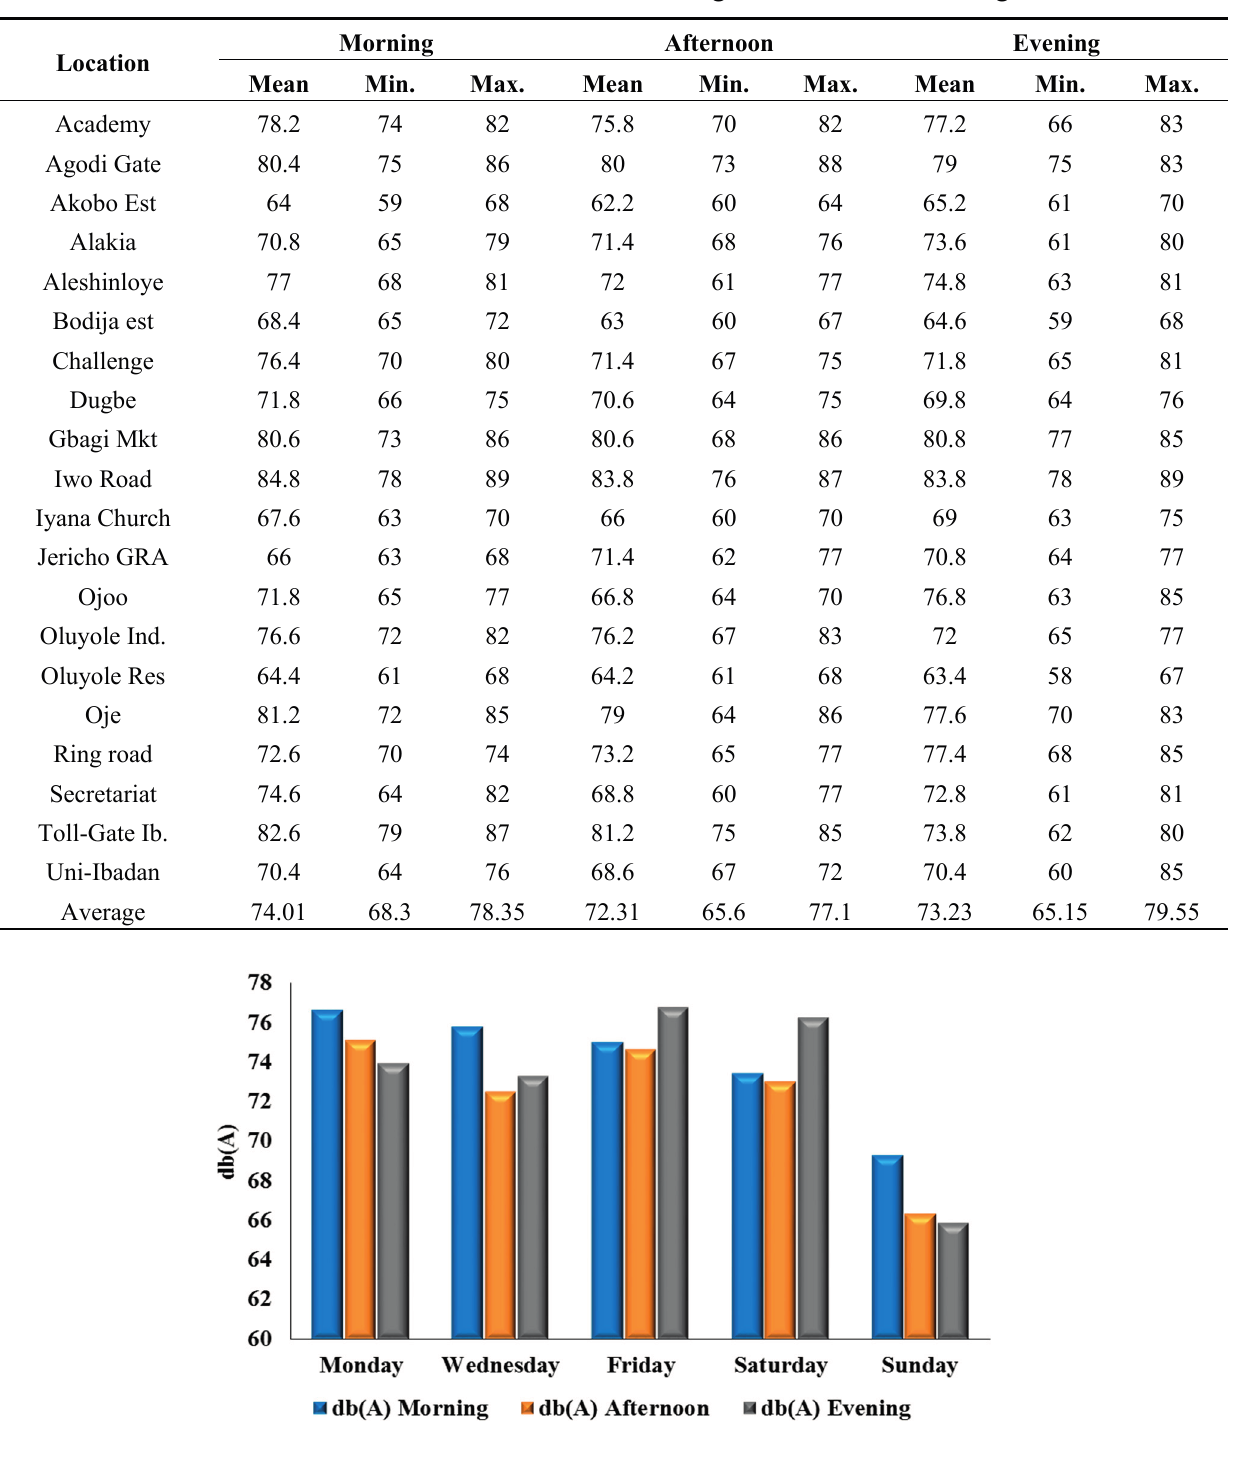
Figure 3. Daily average noise levels in